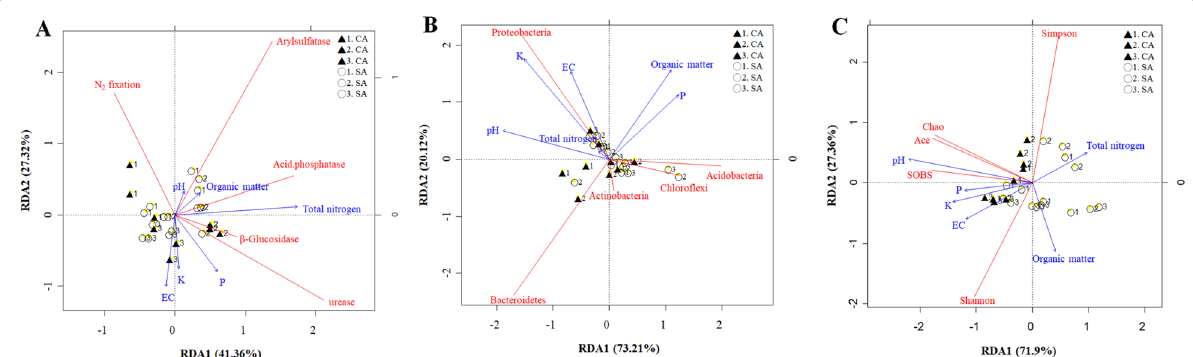
Fig. 6 Redundancy analysis of the temporal variation in the soil characteristics of litchi orchards that were maintained under conventional (CA) and sustainable (SA) agricultural practices. 1, 2 and 3 indicate successive trimester samplings carried out on October 2016, January 2017 and April 2017, respectively. The comparison between the soil properties (pH, EC, K, total N, and OM), and A enzymatic activities, B the most abundant bacterial phyla, and C alpha diversity of OTUs was done by RDA. The RDA plots were generated by the R software in the vegan package